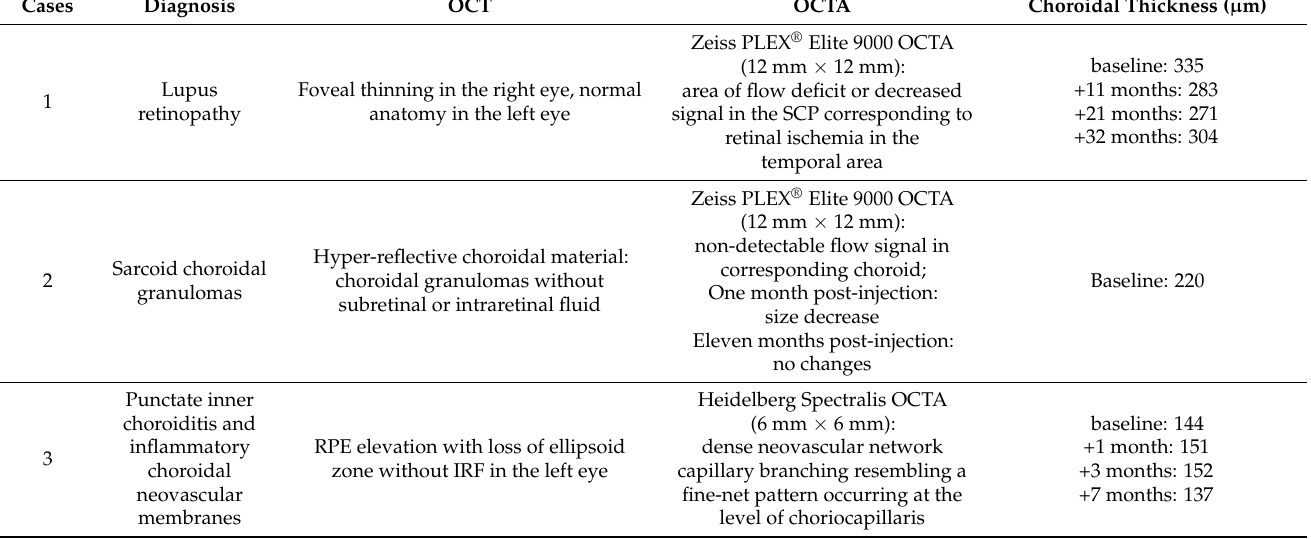
Table 1. Description of diagnosis, imaging findings, and management of the five cases included in the case